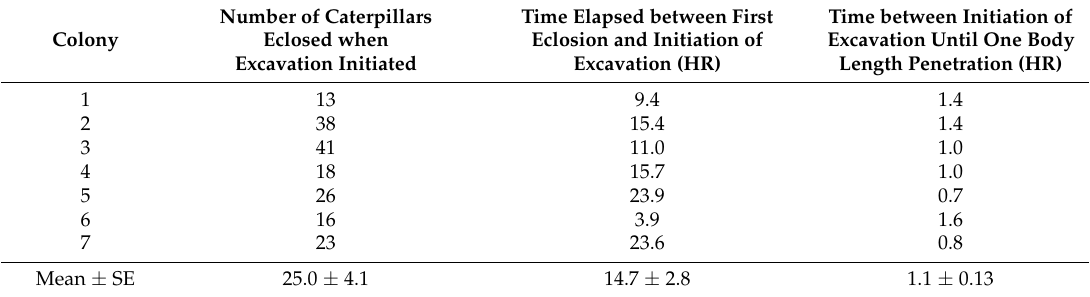
Figure 5. Time elapsed between the first and last caterpillars to eclose from sections of egg sticks held at different relative humidities. Light colored symbols are data points for study 1 and dark colored symbols for study 2. Table 1. Eclosion and initiation of excavation behavior by neonates of Cactoblastis cactorum . Number of Caterpillars Colony Eclosed